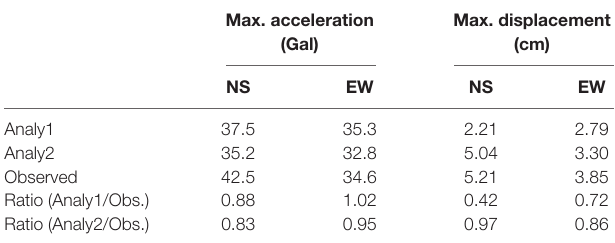
TaBle 7 | Maximum acceleration and displacement responses at 32F (4/11